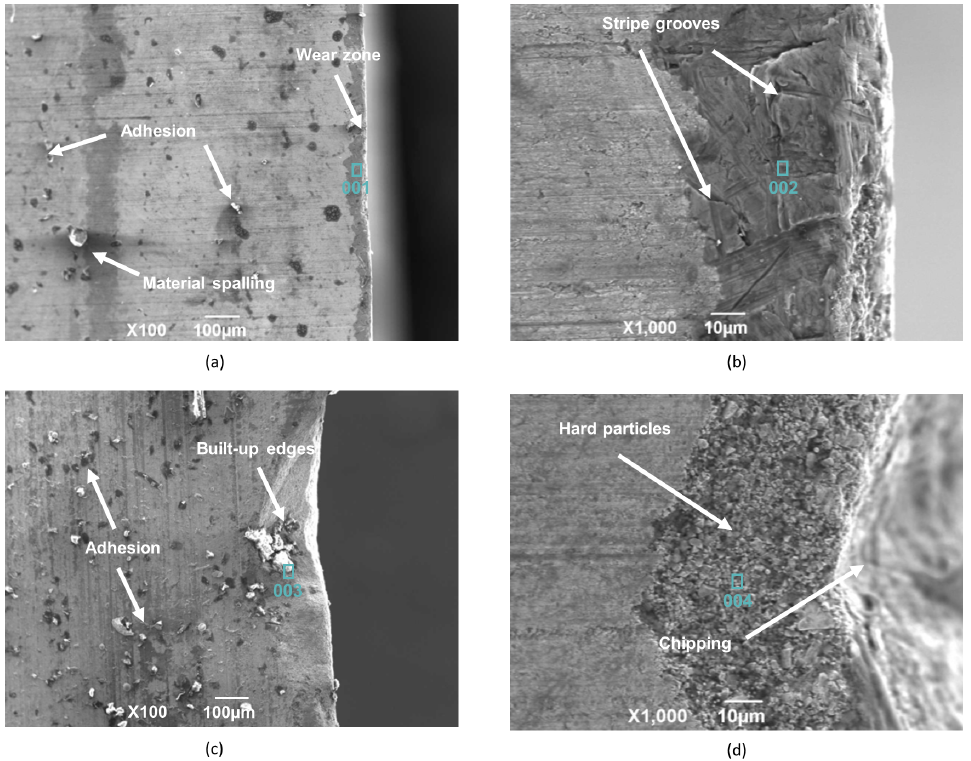
Figure 6. Wear on the center edge of the drill bit during TA10 deep-hole drilling. ( a ) n = 145 r/min and f = 0.06 mm/r; ( b ) n = 145 r/min and f = 0.12 mm/r; ( c ) n = 195 r/min and f = 0.06 mm/r; ( d ) n = 195 r/min and f = 0.06 mm/r.